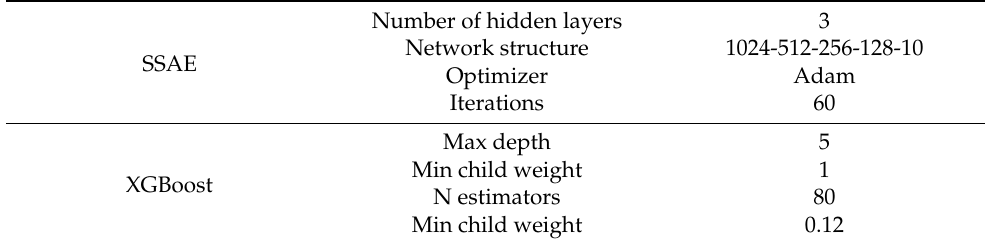
Table 3. Parameter setting of SSAE-XGBoost.